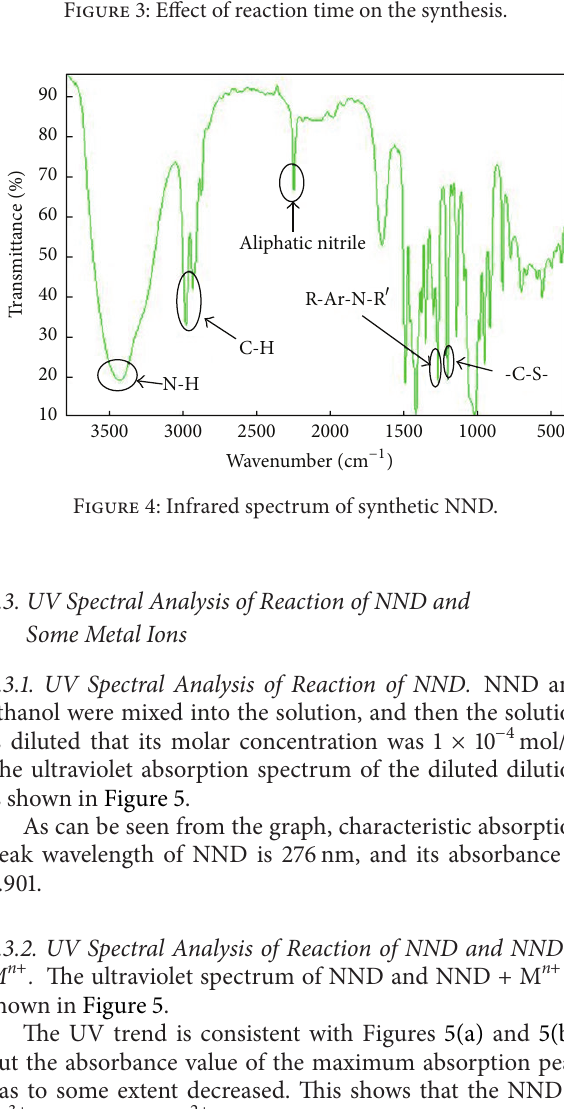
Figure 3: Effect of reaction time on the synthesis.